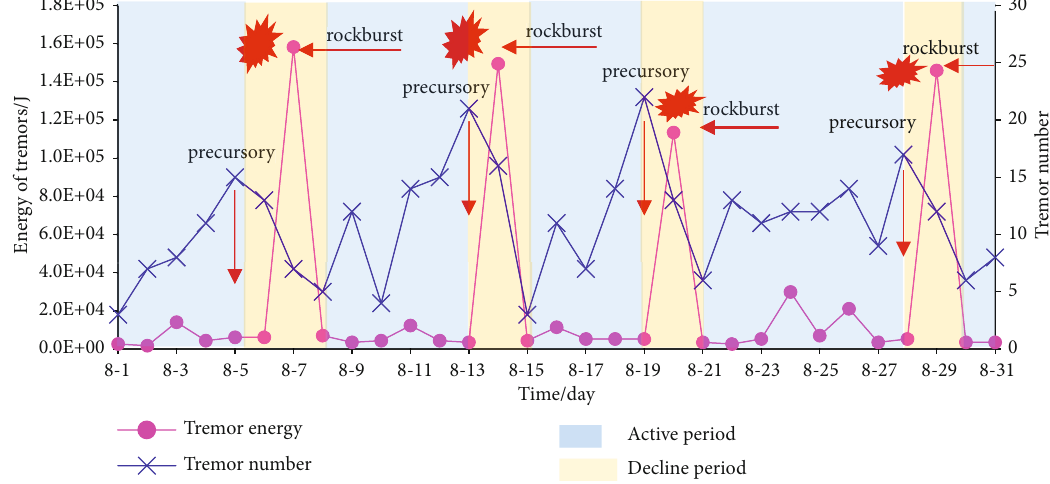
Figure 4: Time-series diagram of MS energy and frequency from Aug 1 to